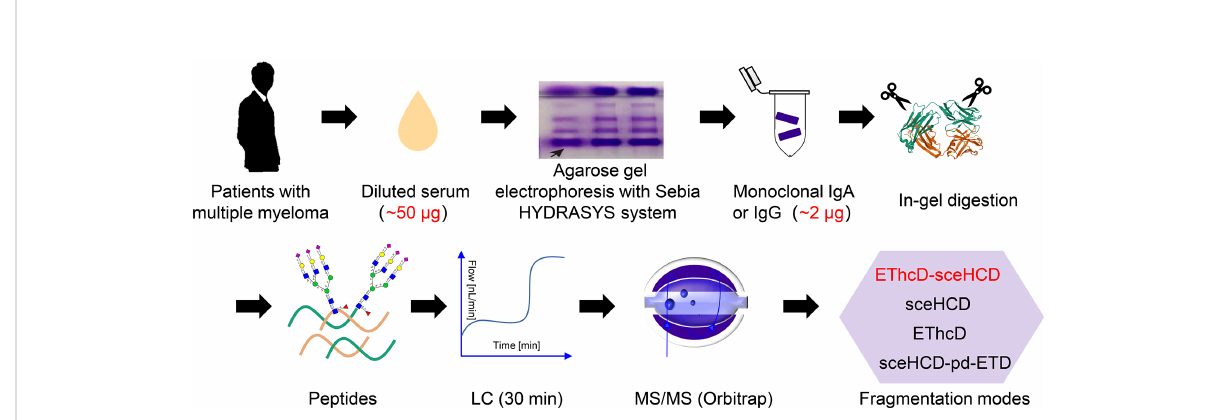
FIGURE 1 Schematic representation of the work fl ow for the intact N-glycopeptide analysis of microscale human serum monoclonal IgA and IgG from patients with multiple myeloma using four different dissociation